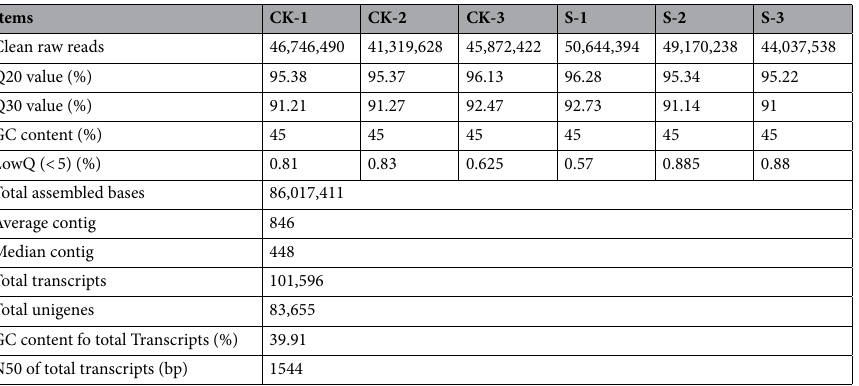
Table 1. Statistical summary of sequencing and assembly